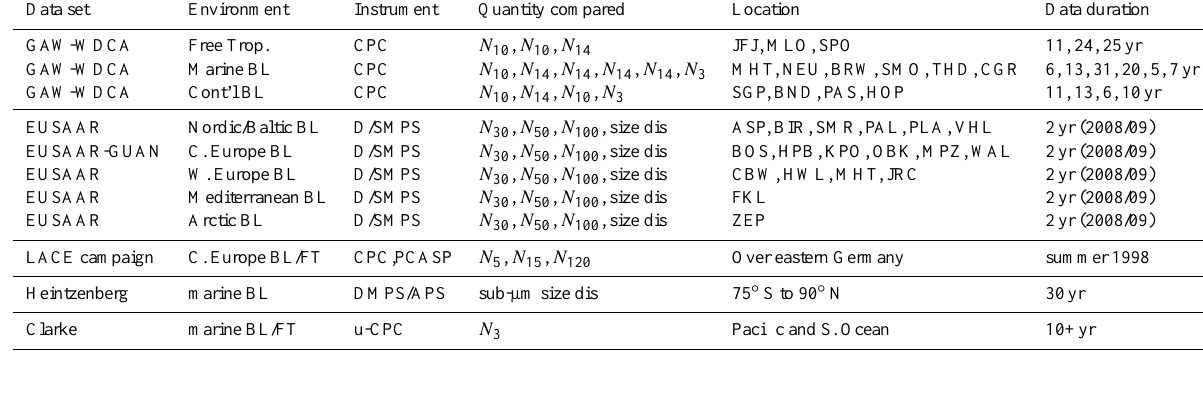
Table 3. Observational data sets on size-resolved number concentrations used in the evaluation of the global aerosol microphysics models. When comparing to the CPC measurements, we derive from the models particle concentrations larger than 3, 10 and 14nm. These size thresholds correspond to the cut-off diameters for the different type of particle counter used in the measurements at each site. Data set